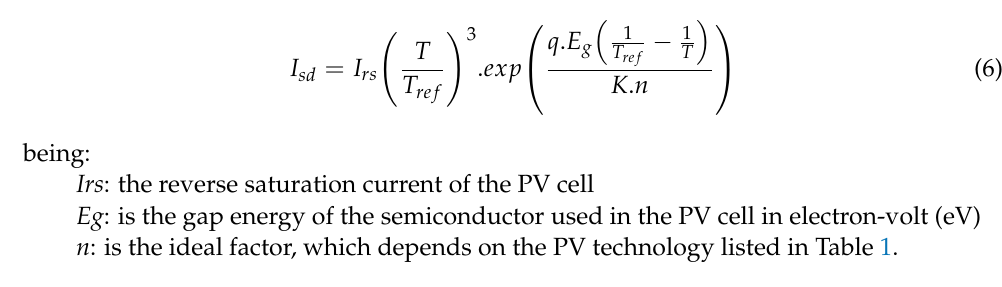
Table 1. Ideal Factor n dependence on PV cell technology. Technology N Monocrystalline Silicon (Si-mono) 1.2 Polycrystalline Silicon (Si-poly) 1.3 Hydrogenated Amorphous Silicon (a-Si:H) 1.8 Hydrogenated Amorphous Silicon tande (a-Si:H tandem) 3.3 Hydrogenated Amorphous Silicon triple (a-Si:H triple) Cadmium Telluride (CdTe) 1.5 Copper Indium Selenide (CIS) 1.5 Gallium arsenide (GaAs)